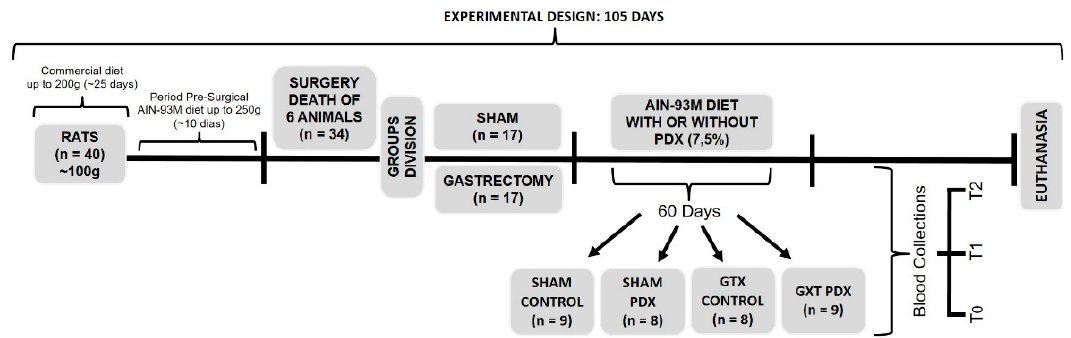
Figure 1. Experimental design. T0 (Time 0): 7 days after the surgical procedure; T1 (Time 1): after 1 month on experimental diet; T2 (Time 2): after 2 months on experimental diet (before euthanasia).